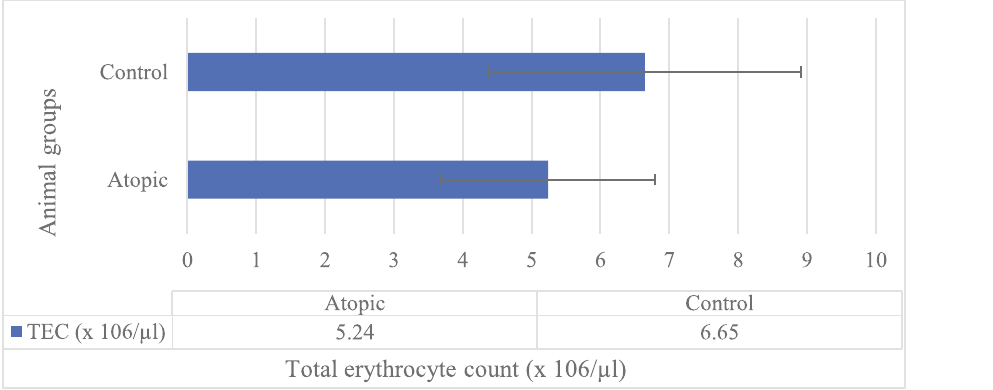
Fig. 1. Mean total erythrocyte count (x 10 3 /µl) in atopic animals and healthy